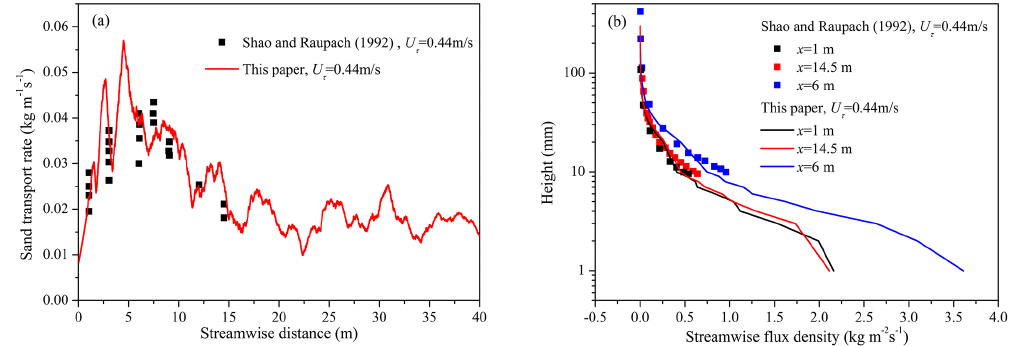
Figure 3. (a) The spatial variation in the streamwise sand transport rate in the sand-laden flow. (b) The streamwise sand transport rate density with the height at the three flow direction positions.